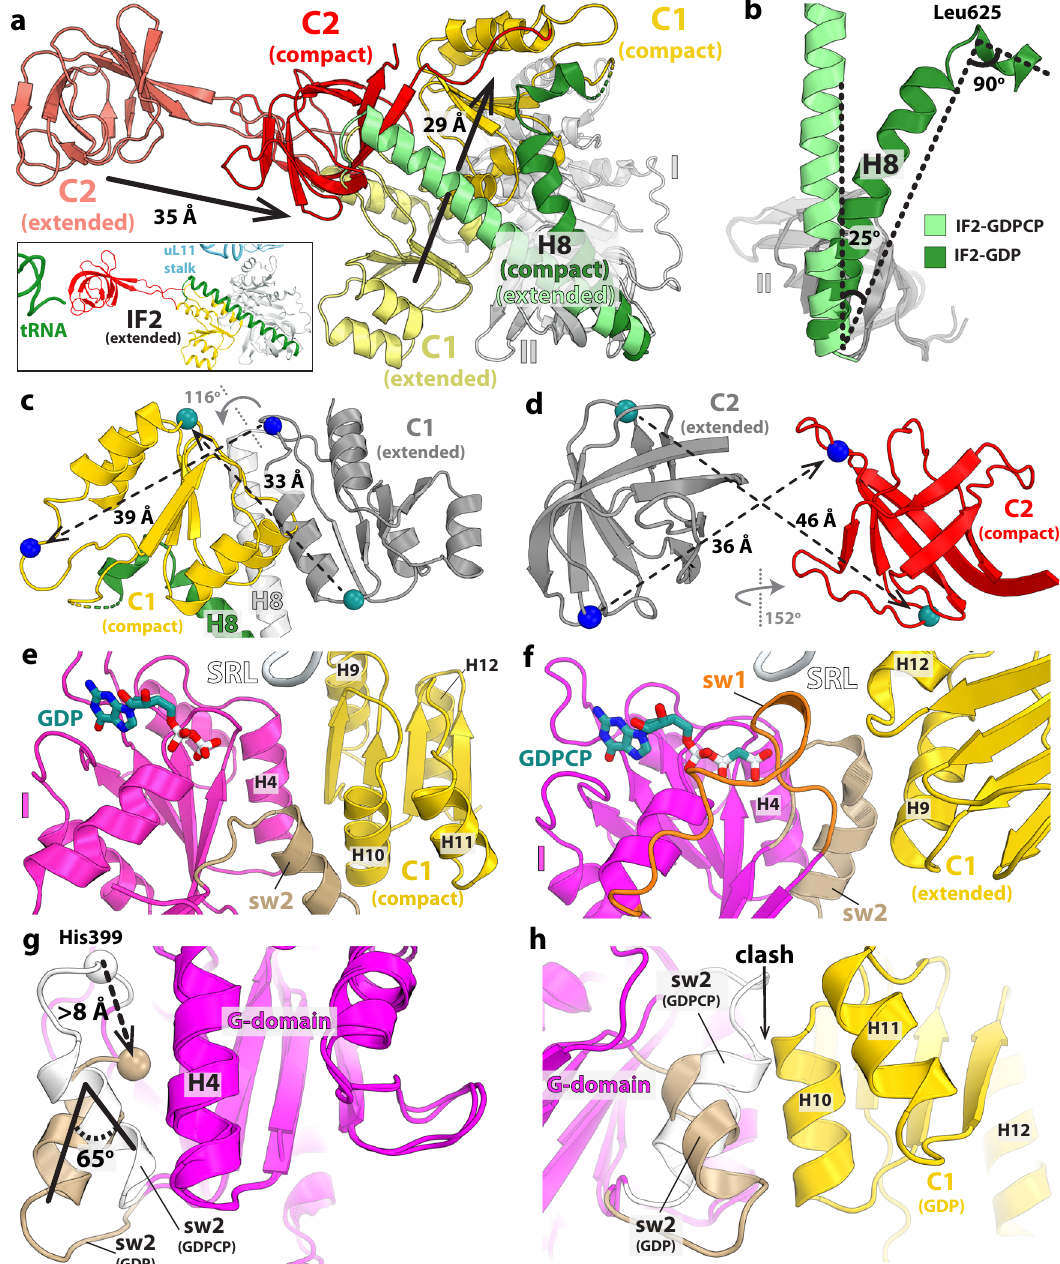
Fig. 3 Structural rearrangements in IF2. a Superimposition of the G-domain (gray) in structures I-A and II-A reveals domain rearrangements between extended (faded colors) and compact (darker colors) IF2. Domains C1 and C2 move by 29 Å and 35 Å, respectively. Inset: Overview of IF2 bound to the 70S-IC viewed in the same orientation. b Alignment of domain II in IF2 shows that helix H8 (green) bends by 25° and turns sharply by 90° around residue Leu 625 to accommodate the displacement of domain C1. c , d Movement of domains C1 and C2 between the extended (gray) and compact (red or yellow) IF2 is accompanied by a rotation of 116° for domain C1 and 152° for domain C2. The displacement of corresponding C α atoms is indicated. e , f Position of domain C1 relative to the G-domain in compact ( e ) and extended ( f ) IF2. In IF2-GDP, helix H10 of the C1 domain (yellow) faces the sw2- α -helix (tan) in the G-domain (magenta) ( e ), while in IF2-GDPCP helices H9 and H12 from the opposite side of domain C1 face the G-domain ( f ). g Rotation of the sw2-helical region by 65° in IF2-GDP forms the new interface with domain C1, displacing the catalytic His 399 residue by more than 8 Å away from the nucleotide- binding pocket. h The conformation of sw2 in extended IF2-GDPCP (white) is not compatible with the location of domain C1 (yellow) in compact